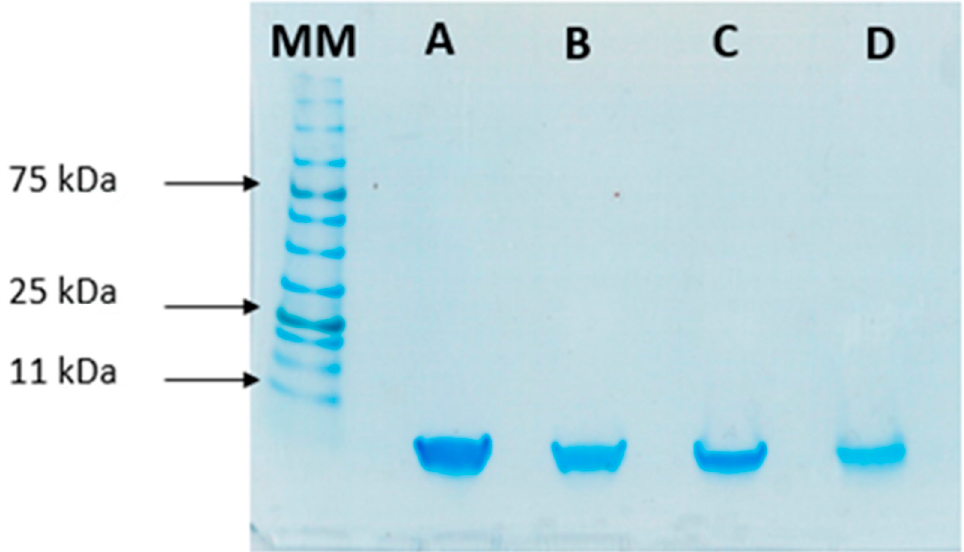
Figure 5. SDS-PAGE analysis of insulin: ( A ) Free insulin (commercial insulin); ( B ) insulin present in total formulation (encapsulated and non-encapsulated insulin); ( C ) insulin in the supernatant after centrifugation of NPs’ suspension; and ( D ) insulin released from the NPs. MM, molecular mass marker (NzyColour protein marker II,